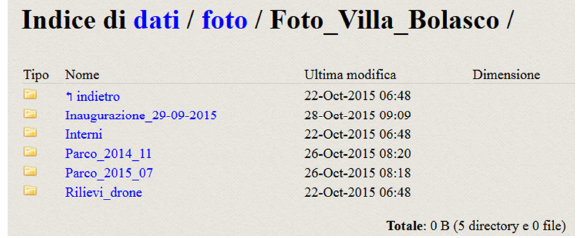
Figure 14. Example of resources available for download.